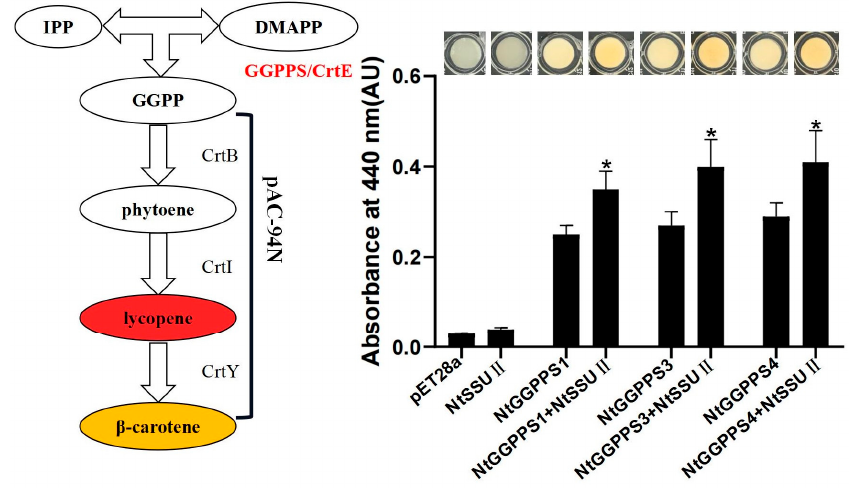
Int. J. Mol. Sci. 2023 , 24 , 992 Figure 3. Subcellular localization of NtSSUs. Subcellular location of NtSSU II, NtSSU I-1, and NtSSU I-2 proteins fused to GFP in tobacco. Chl, chlorophyll autofluorescence.